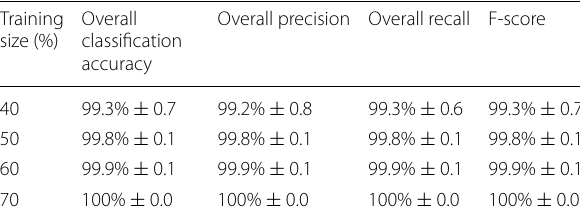
Table 2 Overall classification accuracy, precision, recall, F-score results from the first bearing dataset using the RGBVI-CNN method with 40% to 70% training